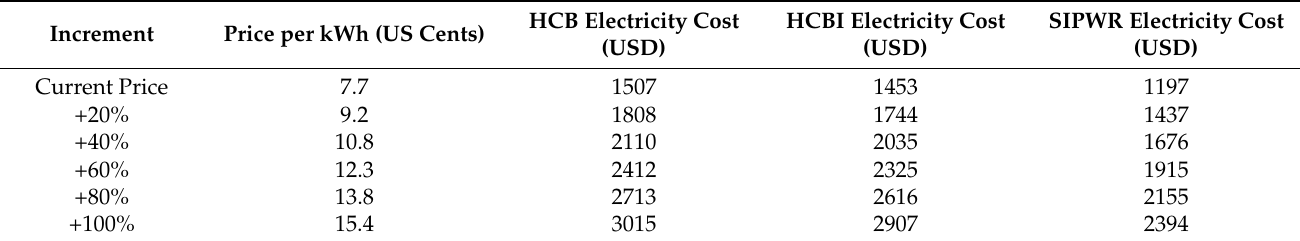
Table 8. New Electricity prices for the Hollow Core Block (HCB), Hollow Core Block-Insulated (HCBI) and the Structural Insulated Panel Wall (SIPWR) house types after incremental increase.